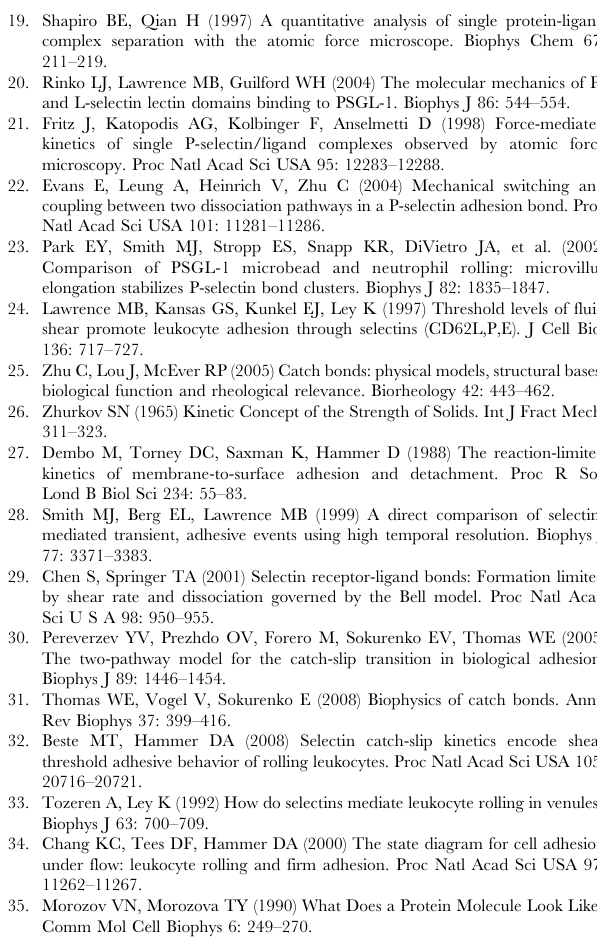
Figure S5 Velocities using the five-parameter catch-slip model dissociation parameters of Evans et al. Instantaneous velocity results from simulations utilizing the dissociation kinetics from the study by Evans et al. are presented as a function of time.